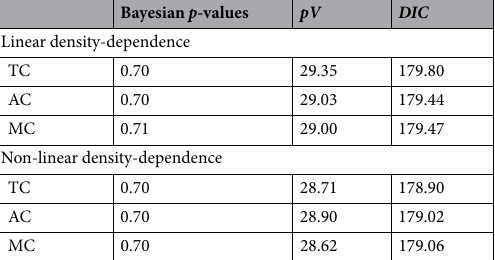
Table 2. Model performance for six alternative models (linear and non-linear density-dependence models under the three bycatch indices) shown as Bayesian p -value, and DIC values giving the estimator of model complexity ( pV ). TC, AC, and MC respectively denote Total Catch, Average Catch and Maximum Catch set estimated to reconstruct bycatch history.